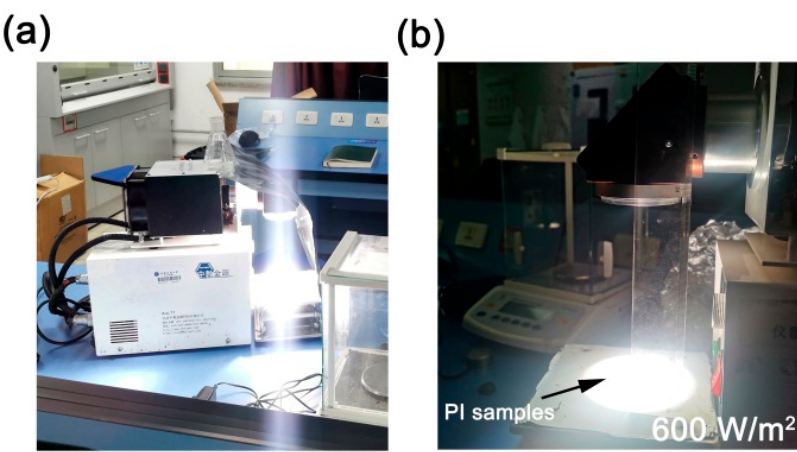
Figure 2. Xenon lamp exposure system. ( a ) test system; ( b ) light source.